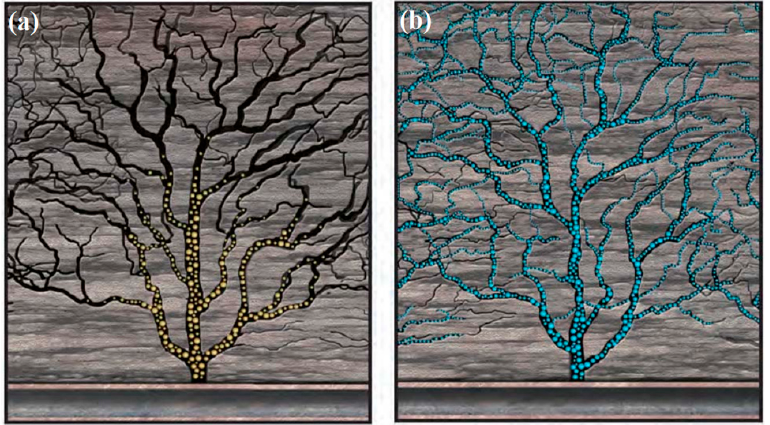
Figure 2. Prop effect of ( a ) traditional proppant and ( b ) low-density proppant